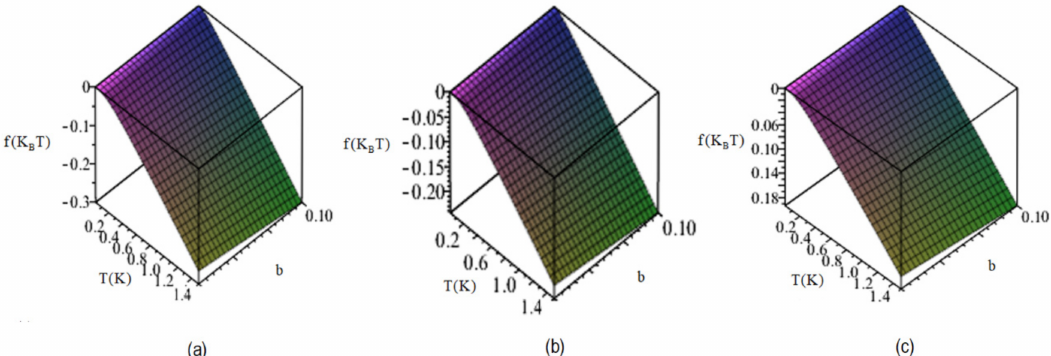
Figure 1. Thermodynamic potential f per magnetic charge. The z axis represents the f-value in K B T energy. The y axis is the temperature in kelvins. The x axis represents the energy b defined in Equation (5) between the values 0.1 and 0.25. θ = 0.625 in ( a ), θ = 0.80 in ( b ), and θ = 1.00 in ( c